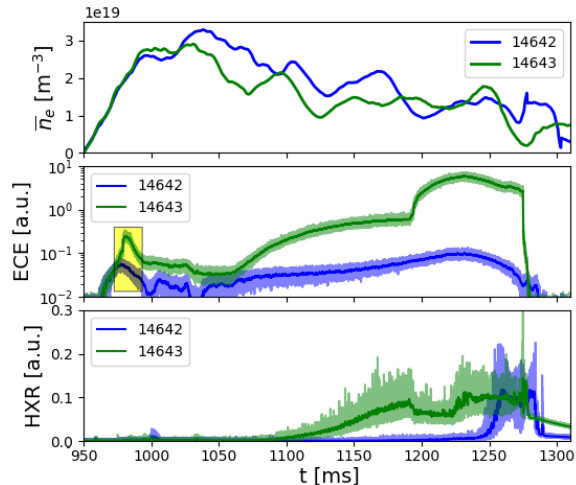
Figure 7. Comparison of the electron density, V-ECE and HXR measurement from the shots 14642 and 14643. Yellow rectangle highlights the runaway seed. (O,ch1)